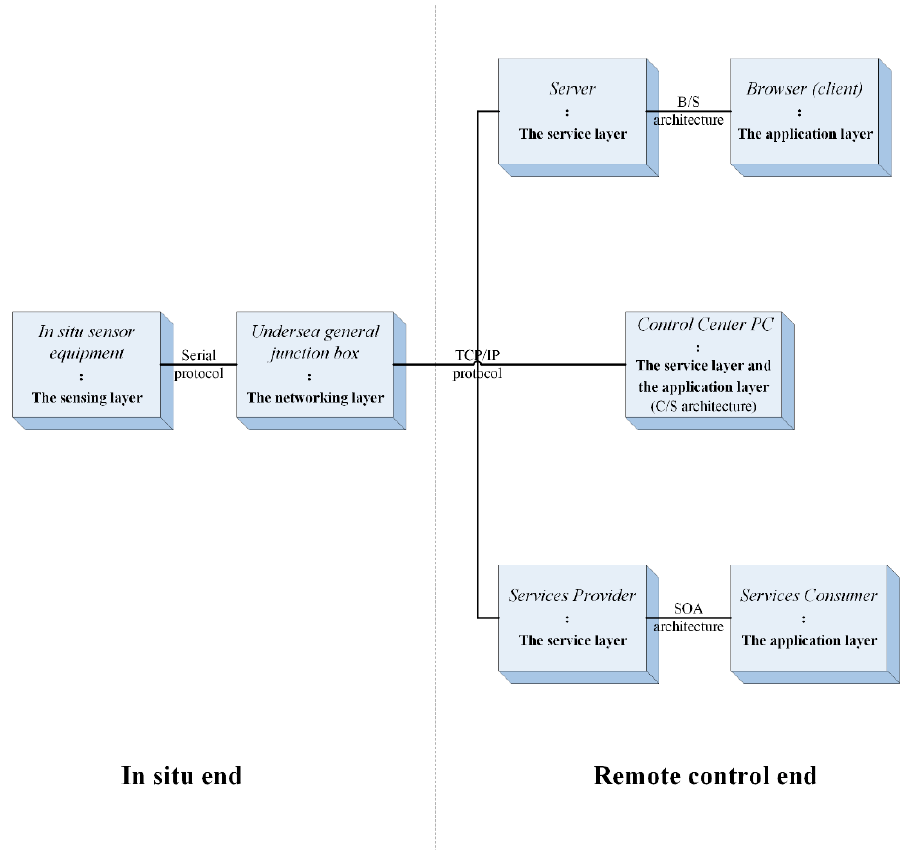
Figure 4. Deployment Scenarios of the Model.